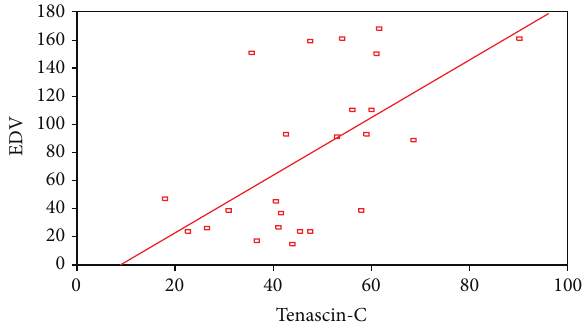
Figure 2: A positive correlation between serum tenascin-c and end diastolic volume in patients.